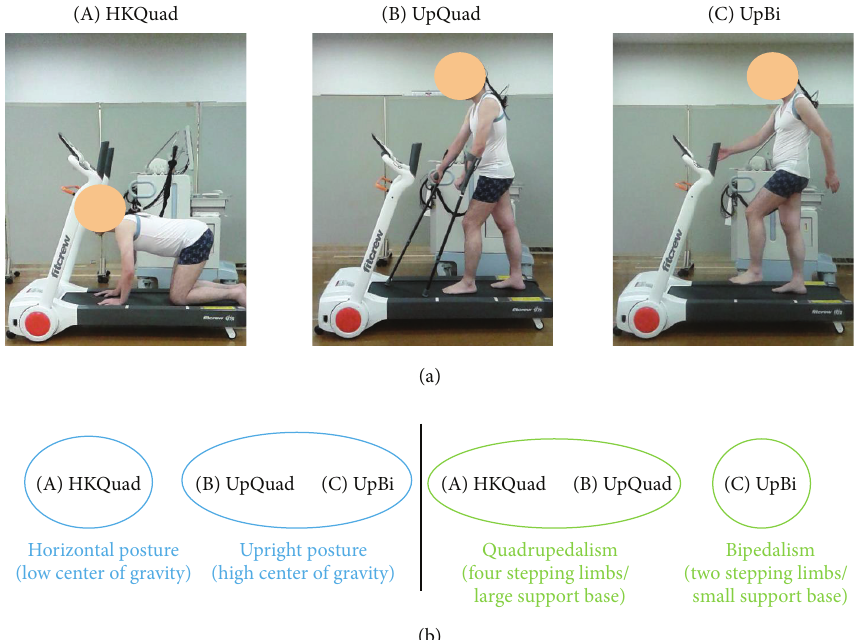
Figure 2: Experimental setup. (a) Images of three locomotor tasks during hand-knee quadrupedal crawling (HKQuad) (A), upright quadrupedalism (UpQuad) using bilateral Lofstrand crutches (B), and usual upright bipedalism (UpBi) (C). (b) The conceptual framework for the task design. Differences in the height of the center of gravity distinguished between HKQuad and the other two tasks (UpQuad and UpBi) (left). The difference in the number of stepping limbs that encompassed the support base distinguished between UpBi and the other two tasks (HKQuad and UpQuad)